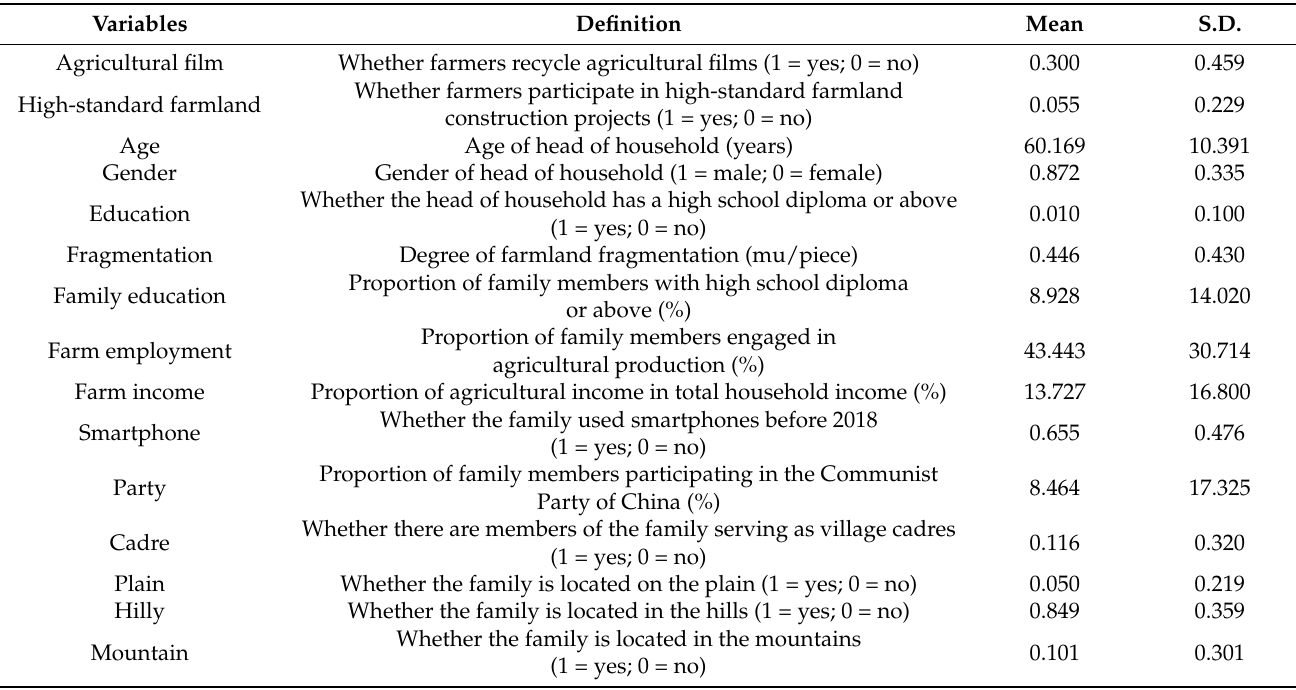
Table 1. Definition of variables and descriptive statistical